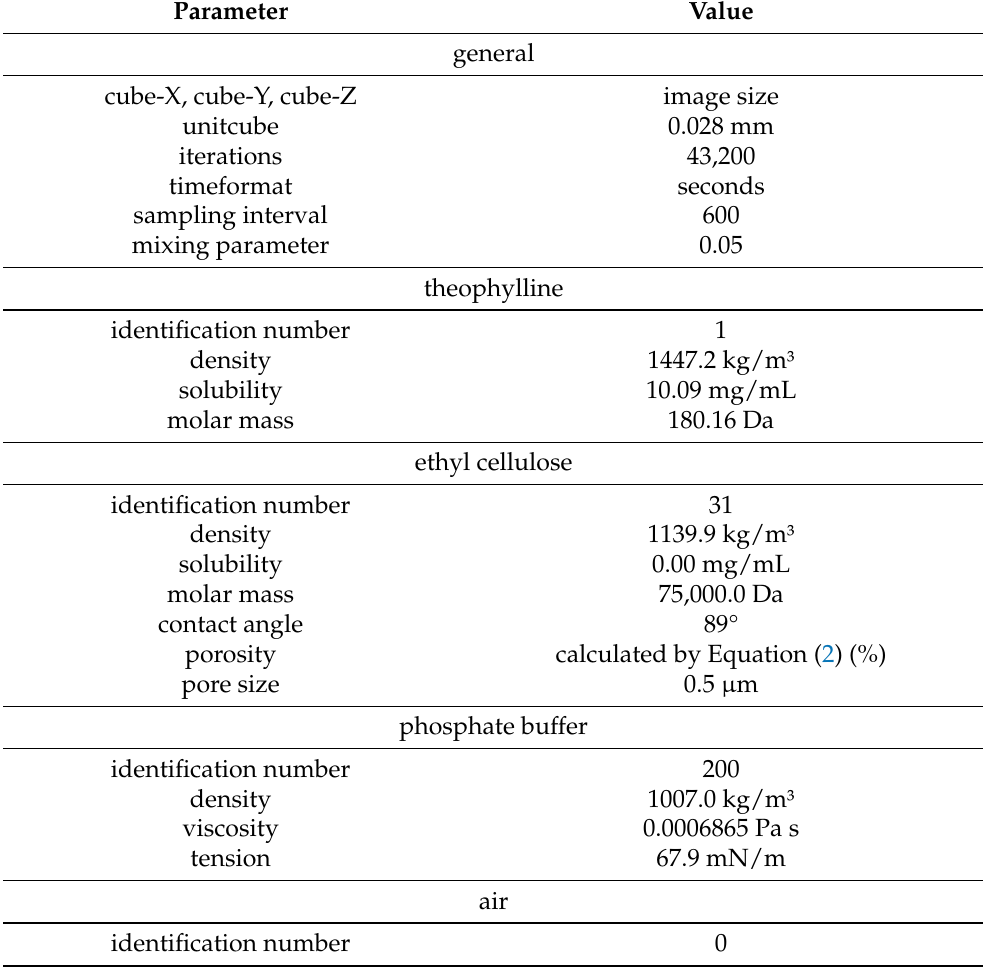
Table 2. The selected parameters for the in silico